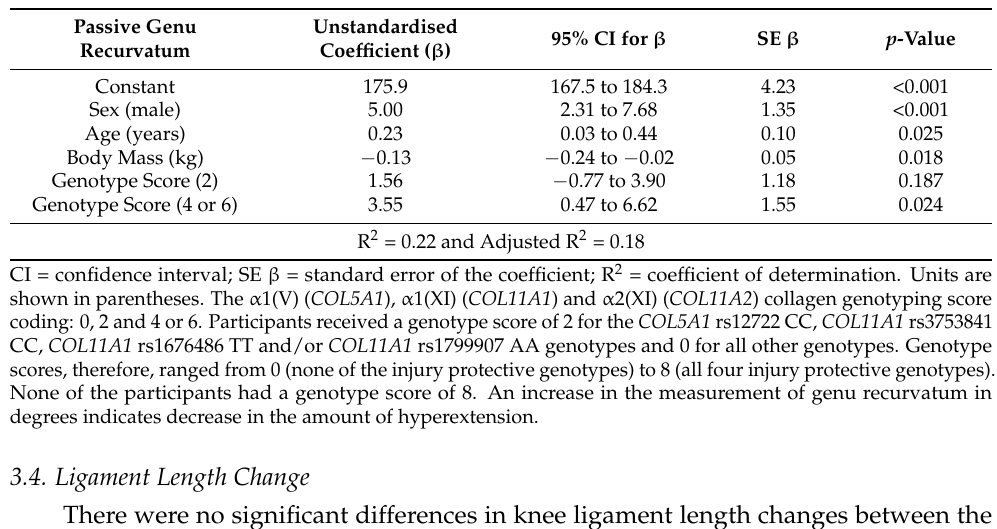
Table 1. Summary of multiple linear regression model for passive genu recurvatum in the non- dominant